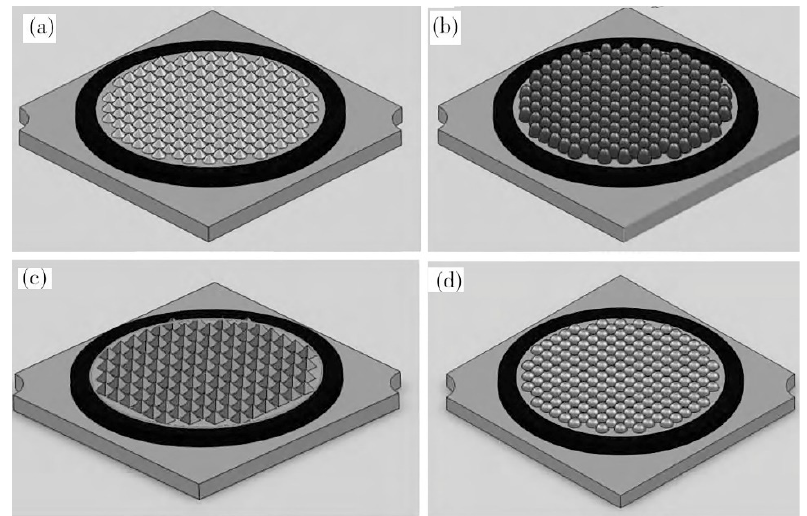
Figure 7. Three-dimensional rendering of the models for the lens of packaged LEDs: ( a ) array cone lens, ( b ) semi-ellipsoidal lens, ( c ) quadrangular pyramid lens and ( d ) semi-spherical lens [62].